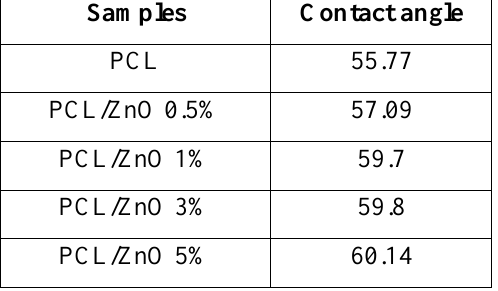
Table 1: Contact angle of pure PCL and PCL /ZnO composites (average value of right and left).